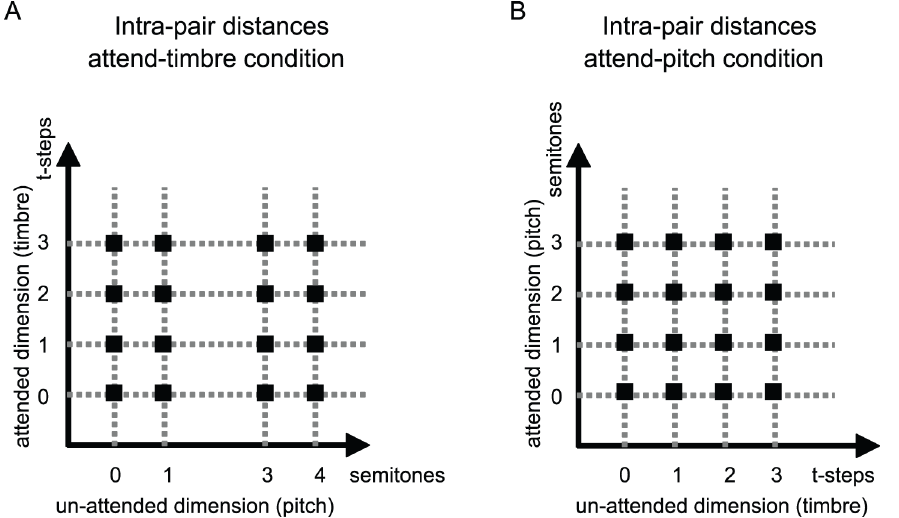
Figure 1. Intra-pair pitch and timbre distances. (A) attend-timbre condition, (B) attend-pitch condition. For each pair of sounds the timbre and pitch variations are indicated in the graphs. For each single sound in the pairs, pitch is related to the fundamental frequency, f 0 , and timbre is related to the width of the Gaussian filter in the spectrum, s k (Equation1). The intra-pair distances in (A), attend-timbre condition, are obtained with sounds parameters: f 0 =300, 318, 378 Hz, s k =16.9, 25.1, 32.6, 48 Hz. The intra-pair distances in (B), attend-pitch condition, are obtained with sounds parameters: f 0 =318, 337, 357, 378 Hz, s k =16.9, 25.1, 48 Hz.